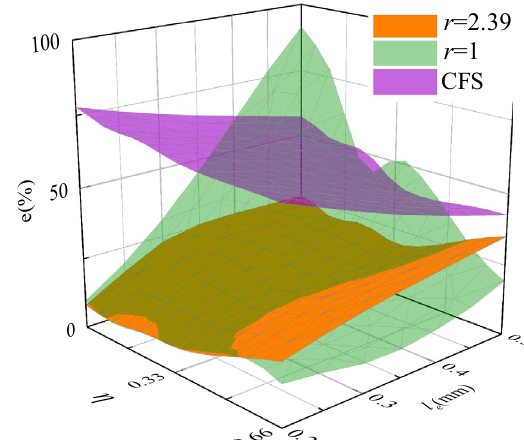
Figure 6 Errors of different failure